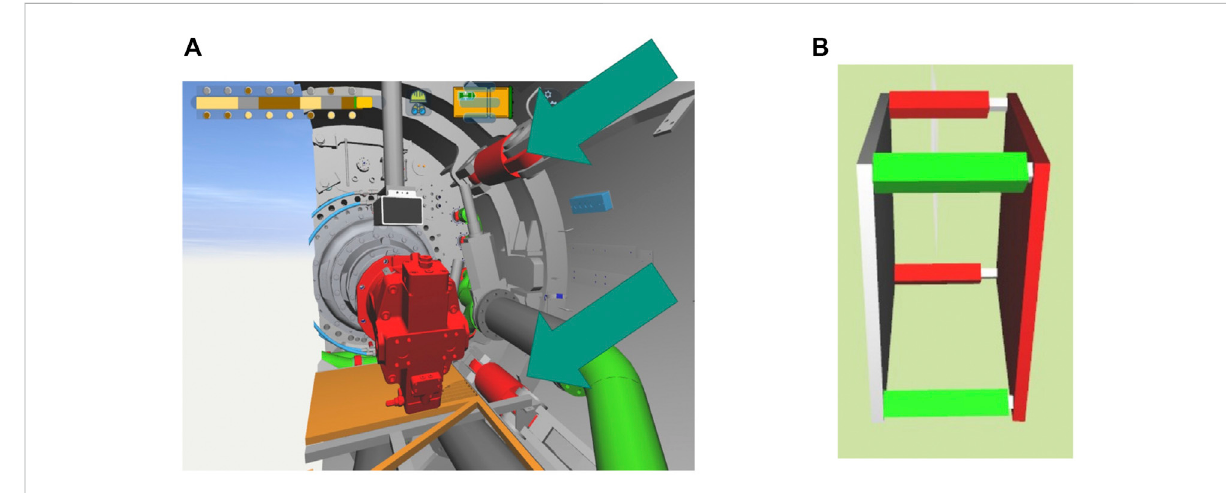
Frontiers in Virtual